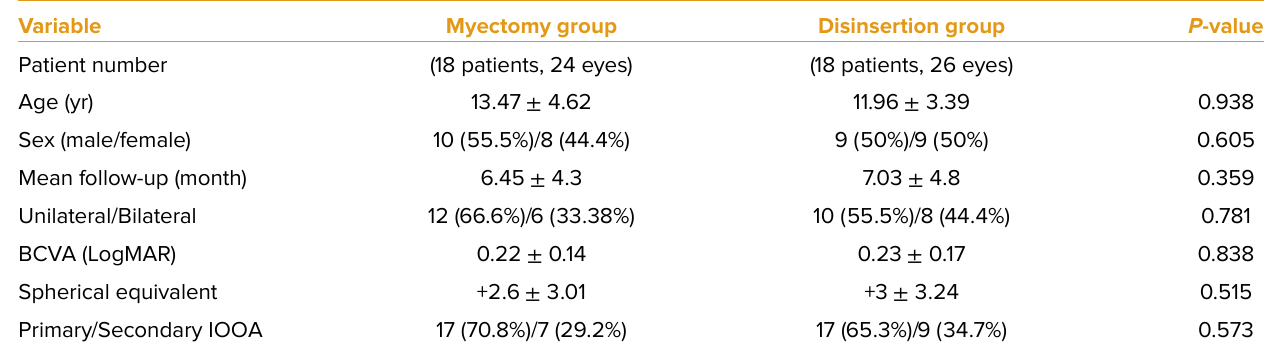
Table 1. Baseline demographic and clinical characteristics of the patients.